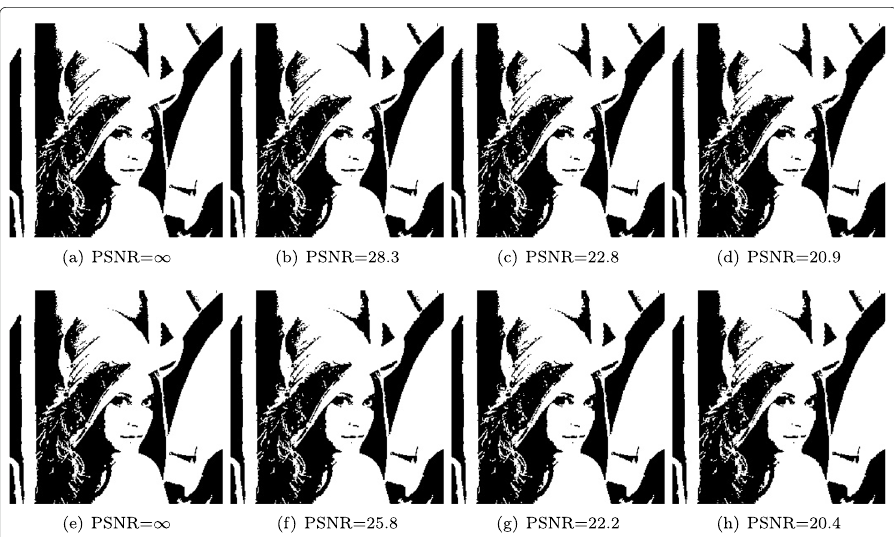
Fig. 8 Visual quality comparison for the proposed scheme and Ren’s scheme [24] with different embedding rates, 0.64, 0.66, 0.68, and 0.70 (bpp). In this experiment, we use the recovery version of Lena image to calculate PSNR values, where e – h are the experimental results using Ren’s scheme and correspond to four embedding rates, respectively, while a – d are the experimental figures using the proposed scheme and also correspond to four embedding rates,